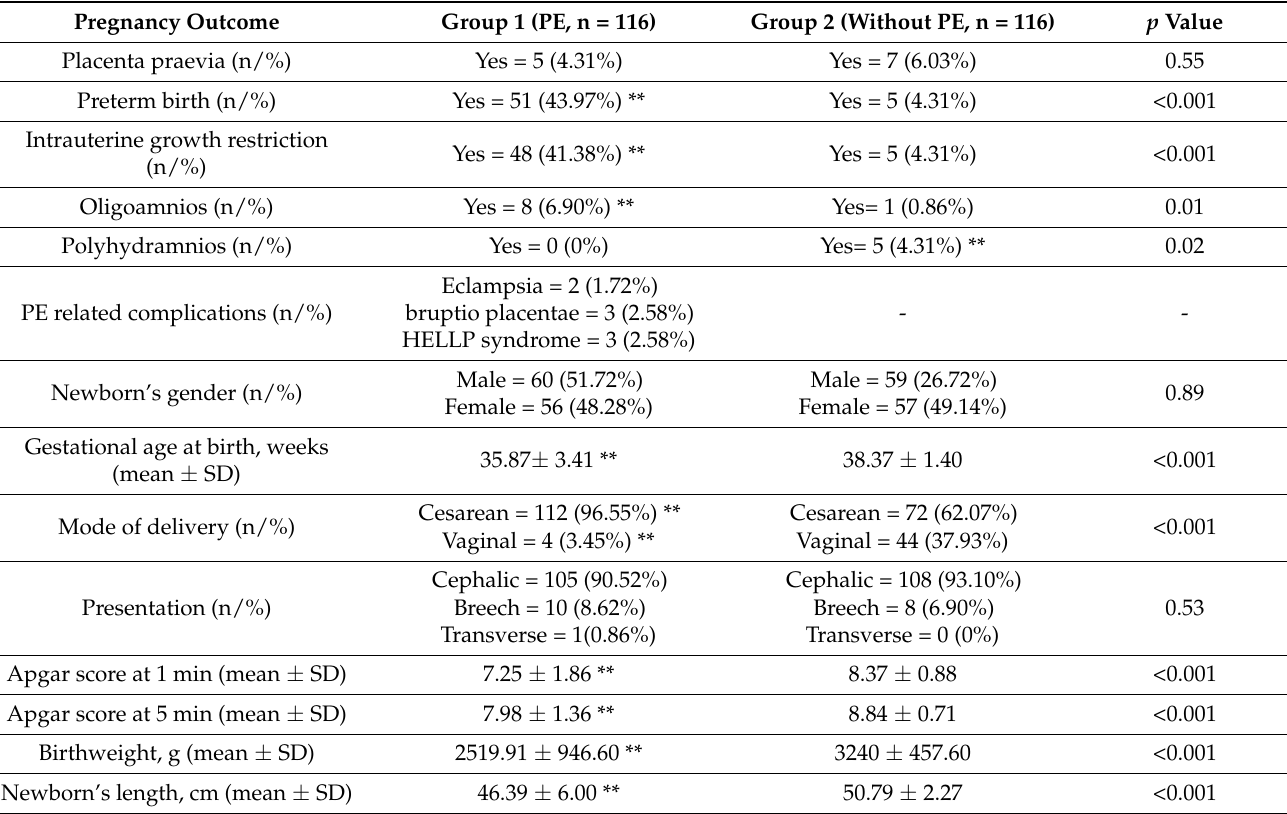
Table 2 legend: PE—preeclampsia; SD—standard deviation; g—grams. Tests used: chi-squared for categorical variables, and t -tests for continuous variables; ** the data from which statistical significance originates. Table 3. Comparison of paraclinical characteristics for the patients included in the analyzed sub- groups.